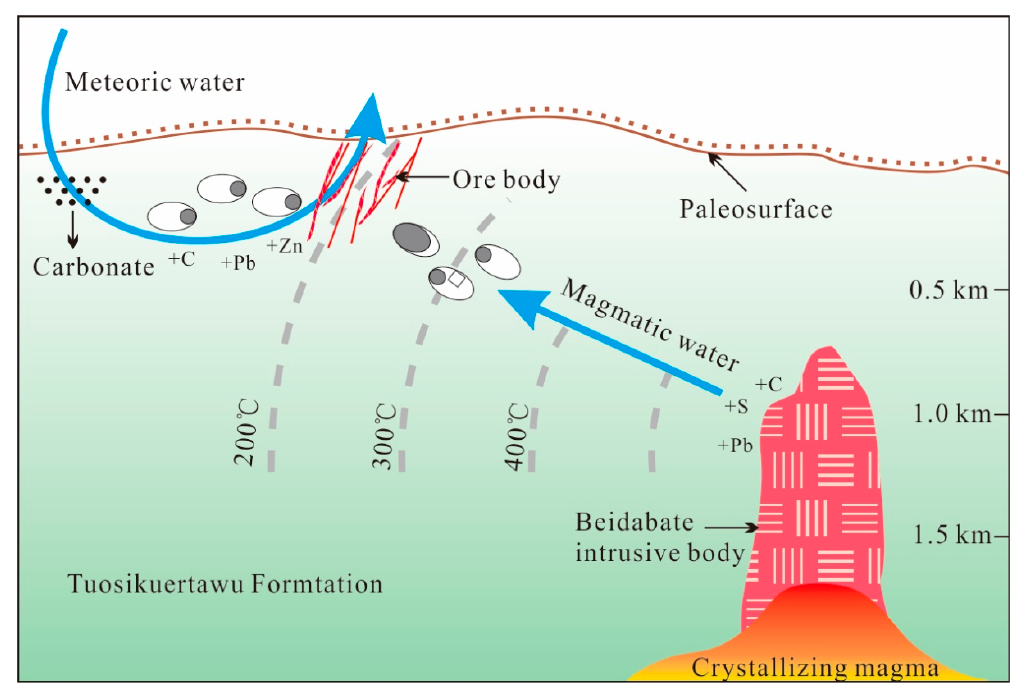
Figure 11. Genetic model diagram of the Kuergasheng Pb–Zn deposit depicting the evolution of the hydrothermal system.